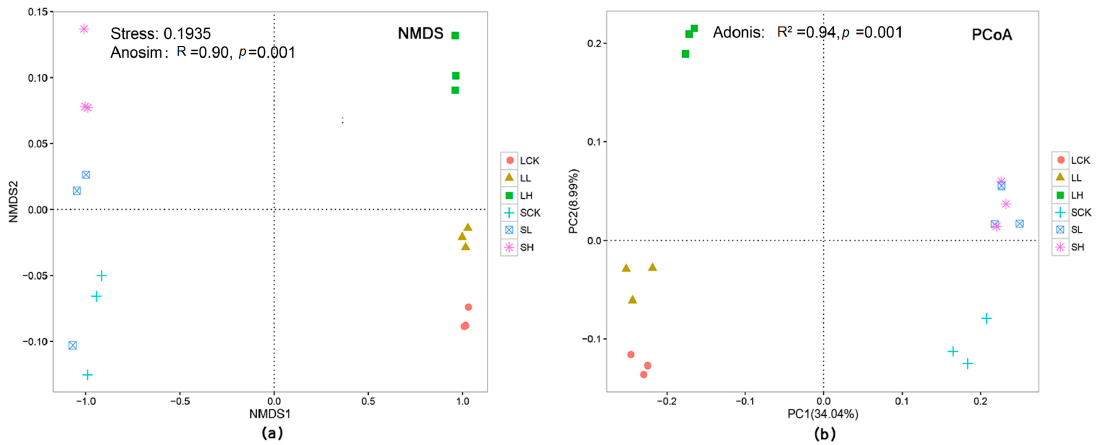
Figure 2. β -diversity of microbial community structure across the different soil treatments. ( a ) Nonmetric multidimensional scaling (NMDS) plot of bacterial Bray–Curtis dissimilarity. ( b ) Principal Coordinate Analysis (PCoA) of 16S rRNA diversity in the paddy soils based on Unweighted UniFrac distances. Each point represents one metagenomic sample ( n = 18). Data representing relative variable importance ( R 2 ) and significance ( p ) calculated by PERMANOVA (Adonis) are displayed.